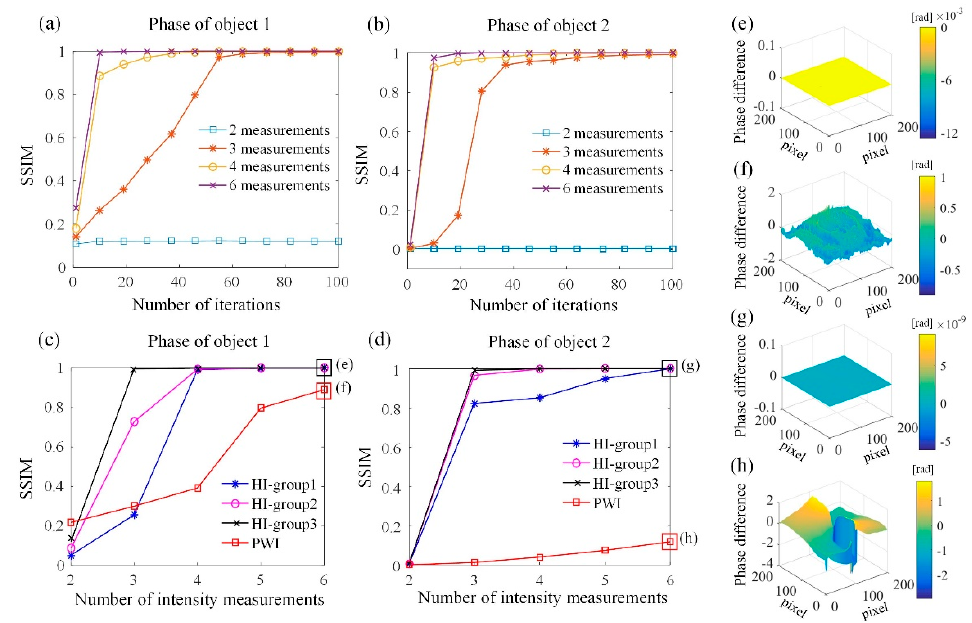
Figure 6. The reconstruction performance with different number of intensity measurements. ( a , b ) are the convergence curves of phase of object 1 and phase of object 2 using HI-group3, respectively. ( c , d ) is the convergence accuracy of the phase of object 1 and phase of object 2, respectively, in terms of the number of intensity measurements for different types of illumination. ( e , f ) is the difference between the simulated and reconstructed phases of object 1 using HI-group3 and PWI, respectively. ( g , h ) is the difference between the simulated and reconstructed phases of object 2 using HI-group3 and PWI, respectively.